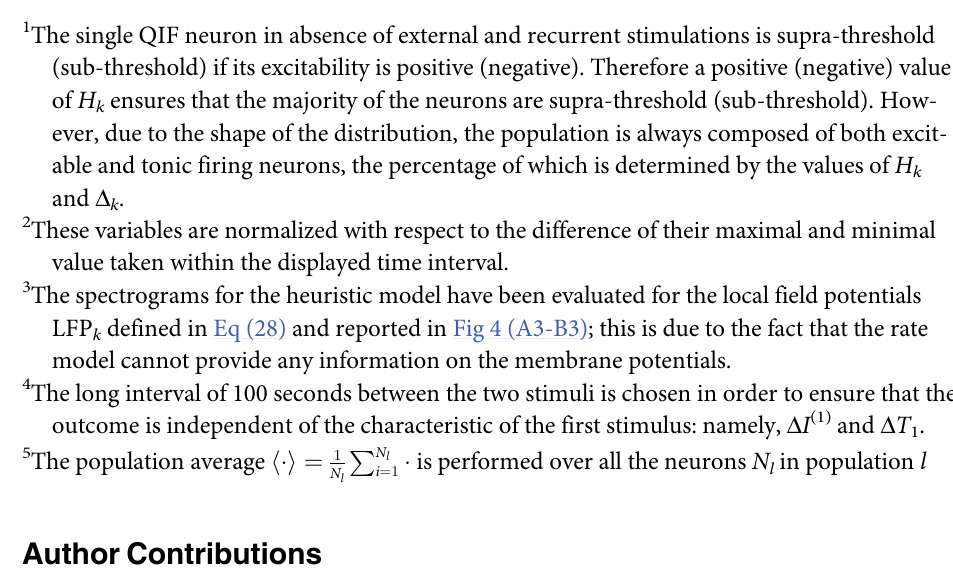
S1 Fig. Maximal capacity. Response of the system when N = 5 excitatory populations are sub- L sequentely stimulated at a presentation rate of 0.8 Hz. Population bursts of excitatory popula- tions ( A ): horizontal lines in absence of dots indicate quiescence phases at low firing rates r k for populations k = 1, . . . 7. Dots mark PBs of the corresponding population. The coloured bars on the time axis mark the starting and ending time of stimulating pulses, targeting each popu- lation. Spectrograms of the mean membrane potential v ( t ) ( B ), v ( t ) ( C ) and of the mean 1 0 membrane potentials averaged over all the excitatory populations ( D ); the corresponding fre- quencies have been denoted as f , f and f . Parameter values as in Fig 1 0 Exc